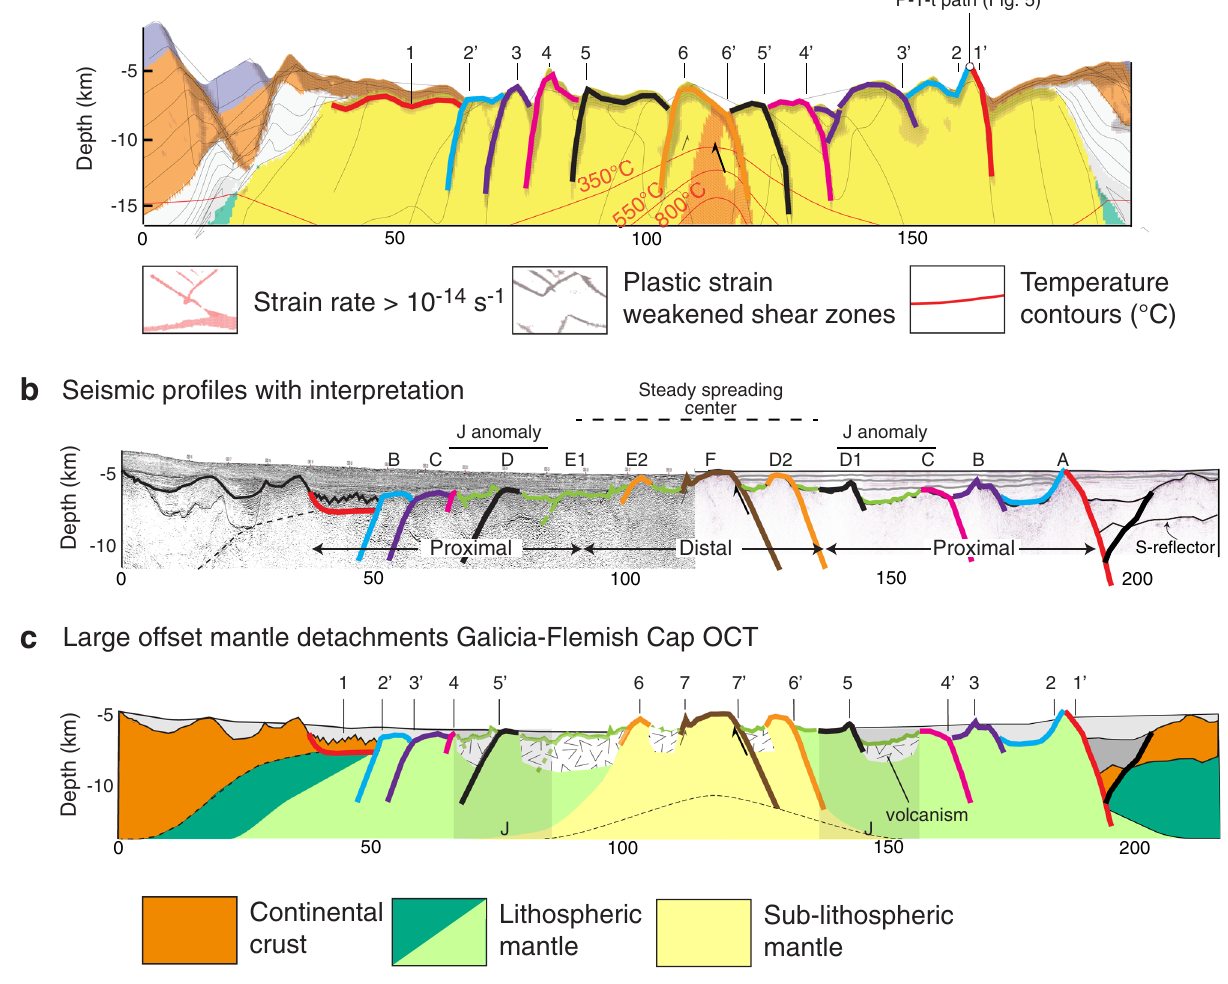
Fig. 4 Forward model prediction of the exhumed mantle, observed transitional domain of the Flemish Cap-Galicia conjugate margins with the interpretation of detachment faults in order of formation. a Model con fi guration at 18.8 Ma. Large offset faults are numbered in sequence of formation linking footwall scarps around the fault breakaway (numbers without a prime) with their detachment fault root zones (numbers with a prime). b Interpretation of the transitional magma-poor domain on top of the seismic pro fi les in terms of conjugate footwall scarps and their detachment fault root zones (colored) and magmatic additions (green). West of dome E2, Hopper et al. 6 argue for the presence of a continuous 2 km oceanic crust (Fig. 2c). The domain between highs C and E2 exhibits a rough high-frequency top basement topography with a small amplitude that we interpret as small offset high- angle faults associated with volcanism. The top basement morphology on Galicia side with similar characteristics is also interpreted as magmatic addition. The position of the J anomaly is located at the transition from incipient volcanism to a steady spreading center. c Same interpretation of the transitional magma-poor domain in terms of conjugate footwall scarps (numbers without a prime) and their detachment fault root zones (numbers with a prime) and nature of the transition zone. Incipient volcanism starts after detachment 4. Note that interpretation of the nature of the ultra-distal small blocks as remnants of continental crust here on top of detachment 1 on Flemish Cap side is similar to Sutra et al. 49 but that the kinematic we infer for their formation differs from their short-offset high-angle normal faults and related rotated mantle blocks sitting on top of a long-offset detachment fault (see supplementary Fig. S10). Models without the increase of thermal conductivity with low temperature at shallow depths result in lower topographic highs and smaller wavelength for a given extension rate owing to slower cooling and a thinner brittle layer (see supplementary Fig. S15).